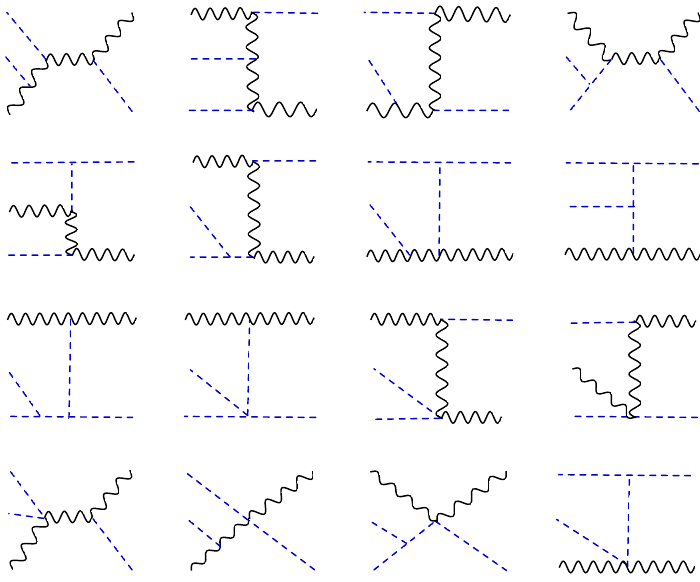
Figure 13 . Feynman diagrams for the annihilation XSS ! XS .